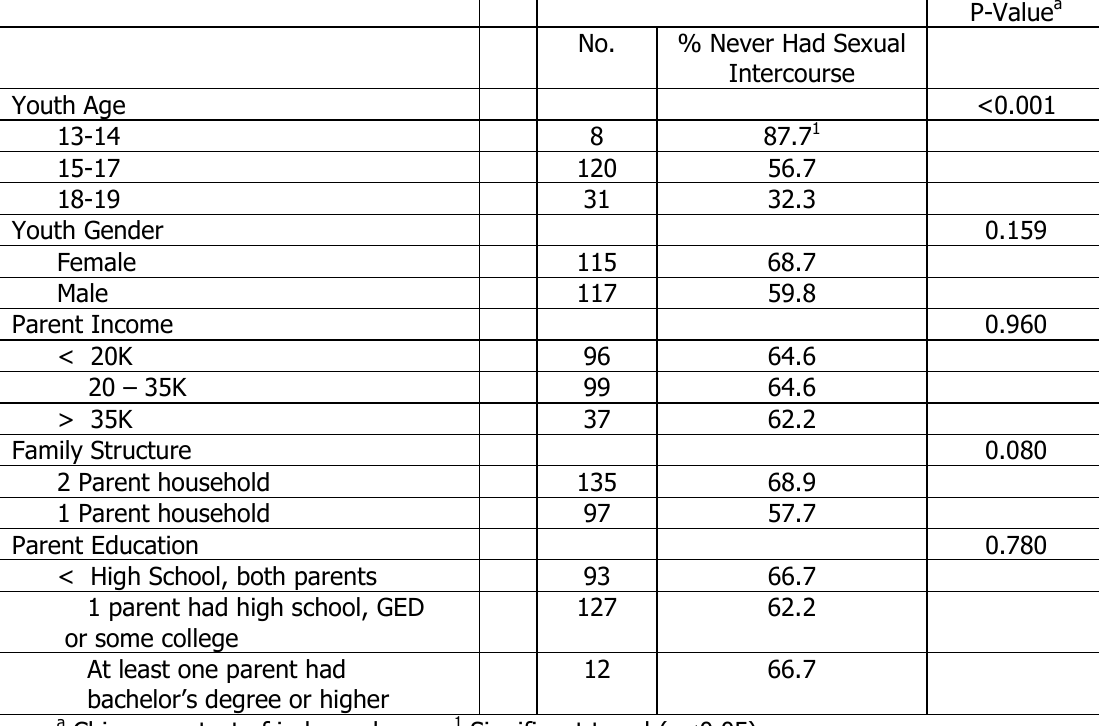
Frequencies and Chi-Square Values for Youth and Parent